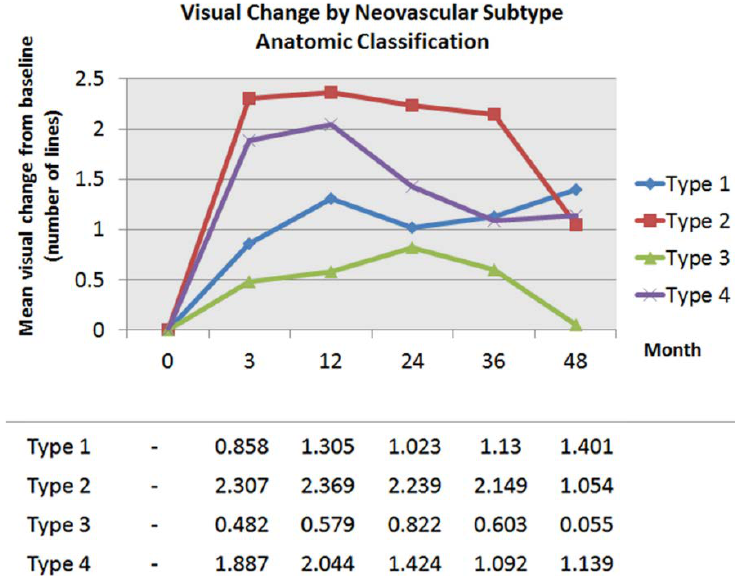
Figure 4. Mean visual change from baseline in line equivalent by neovascular subtype using the anatomic